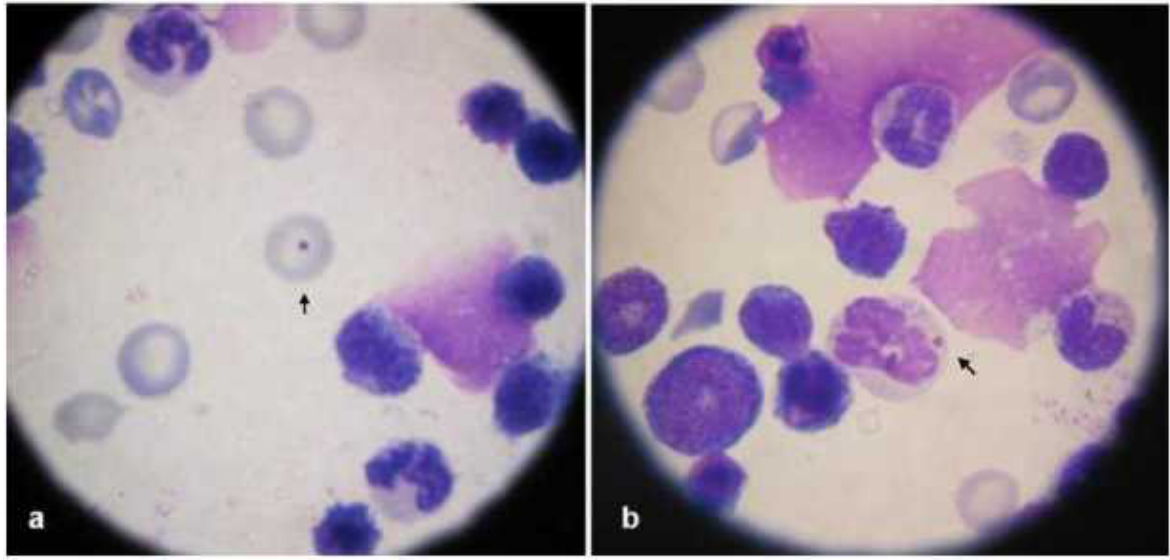
FIGURE 1. Micronucleated bone marrow cells. (a) Micronucleus in a PCE, (b) micronucleus in a polymorphonuclear cell. Arrows indicate the micronucleated